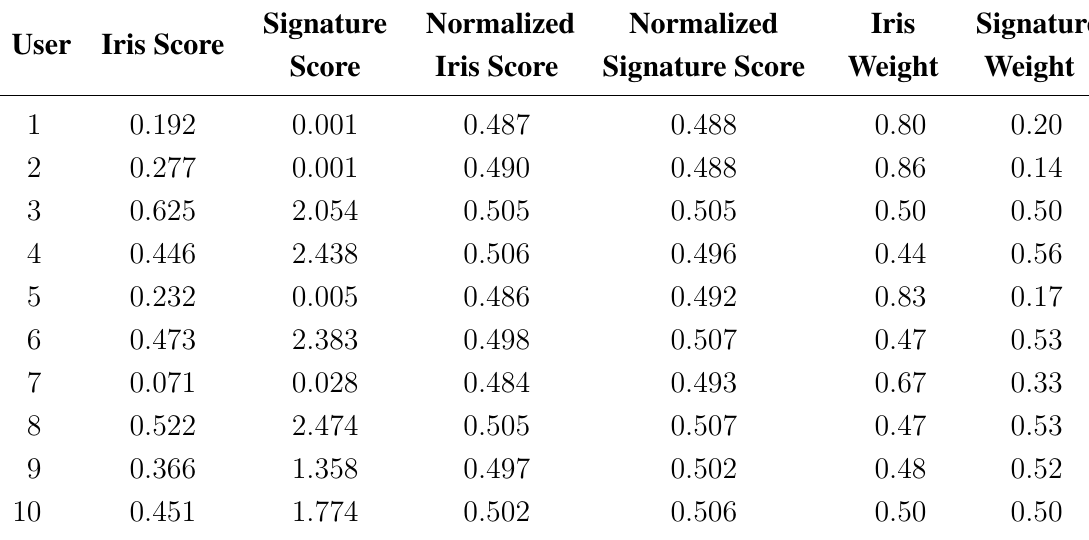
Table 1. User-specific Scores and Weights of different traits for 10 users.